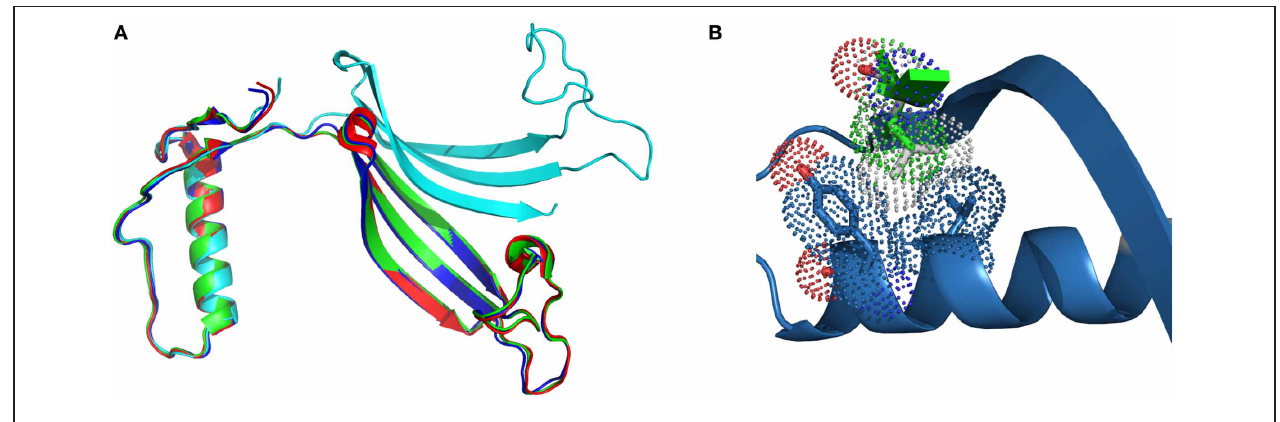
FIGURE 2 | Comparison of (A) the crystal structure of hCC wt (red, PDB code: 1G96) and its variants: L68V (green—pH 4.0, PDB code: 3PS8; cyan—pH 8.0, PDB code: 3QRD) and V57P (blue, PDB: